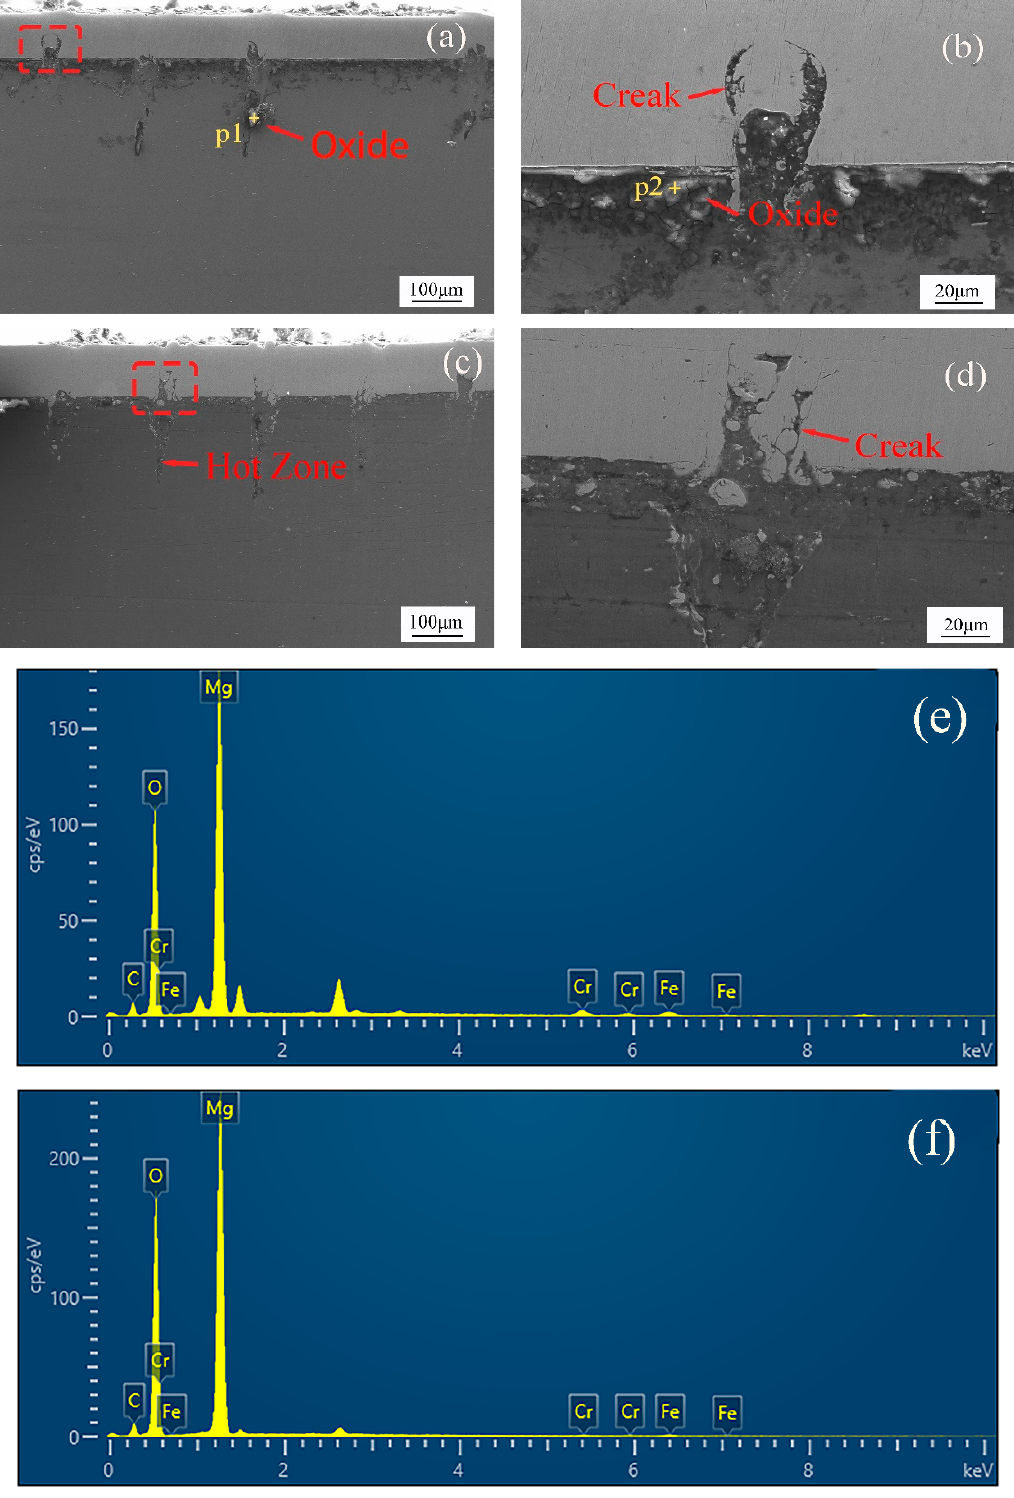
Figure 5. Microstructure and interfacial element distribution of the welded joints: ( a , b ) laser power 15 W, ( c , d ) laser power 20 W, ( e ) element distribution at p1, ( f ) element distribution at p2.